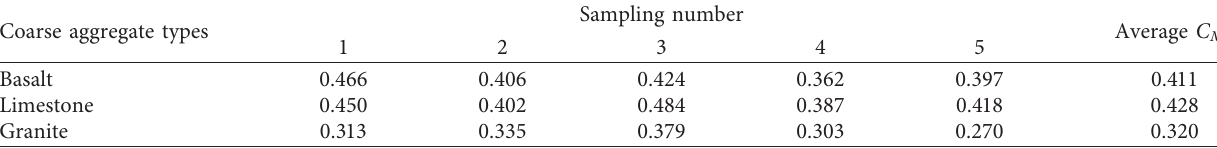
Table 4: The microtexture parameter C